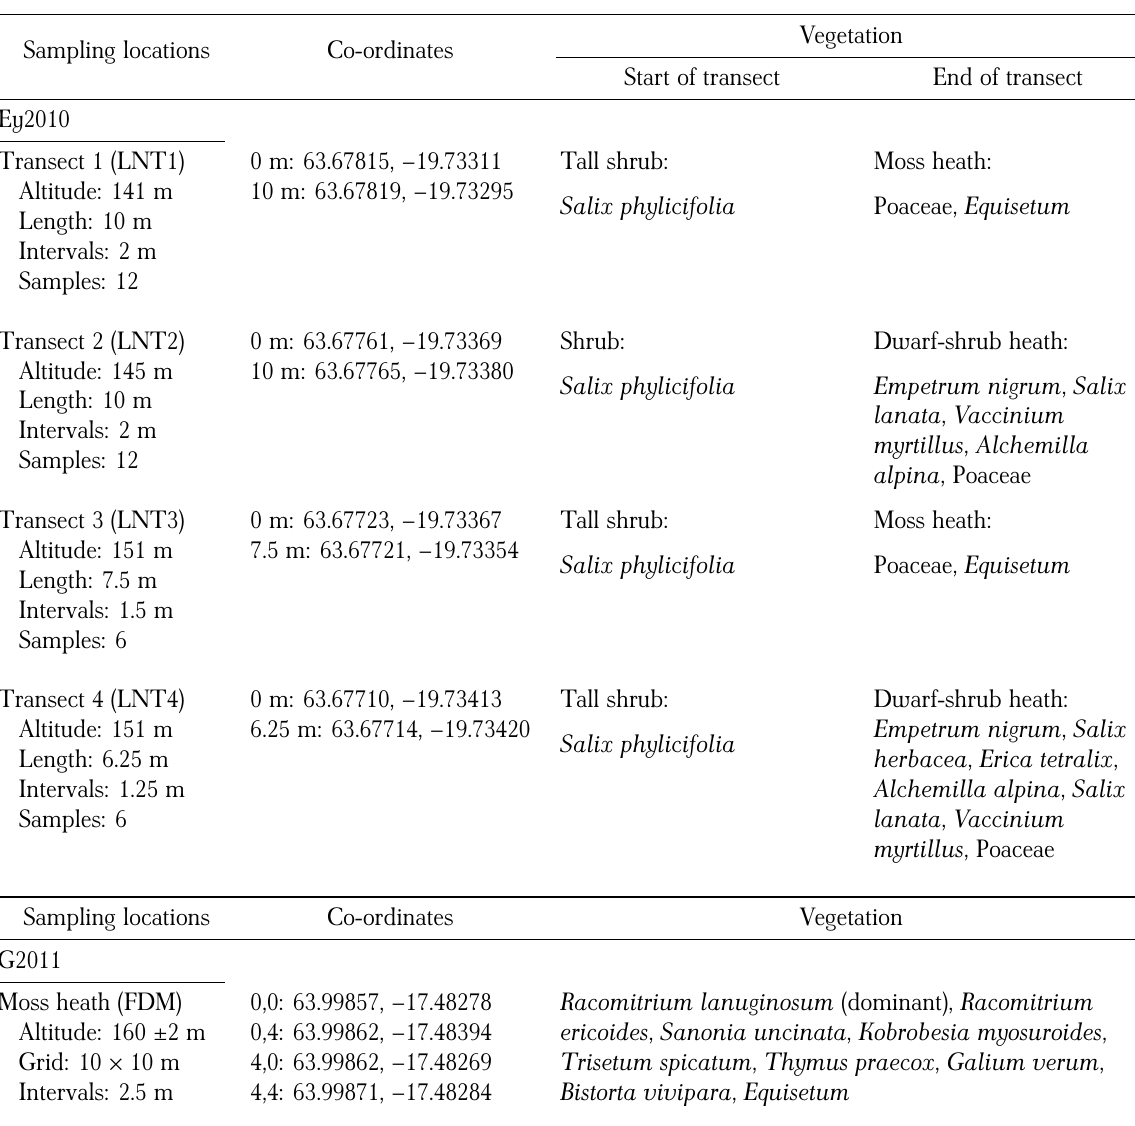
Table 2: Vegetation cover and sampling site details at Langanes (transects) and Fossdalur (grids; vegetation information from Cutler et al.